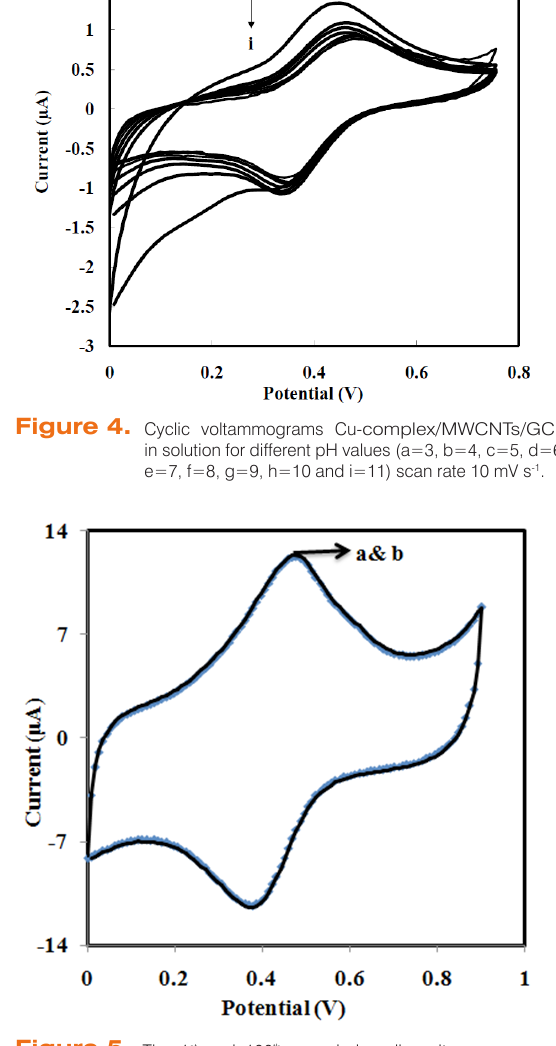
Figure 5. The 1 st and 100 th recorded cyclic voltammograms of modified Cu- complex/MWCNTs/GCE in 0.10 M buffer solution (pH 7) (scan rate 100 mV s -1